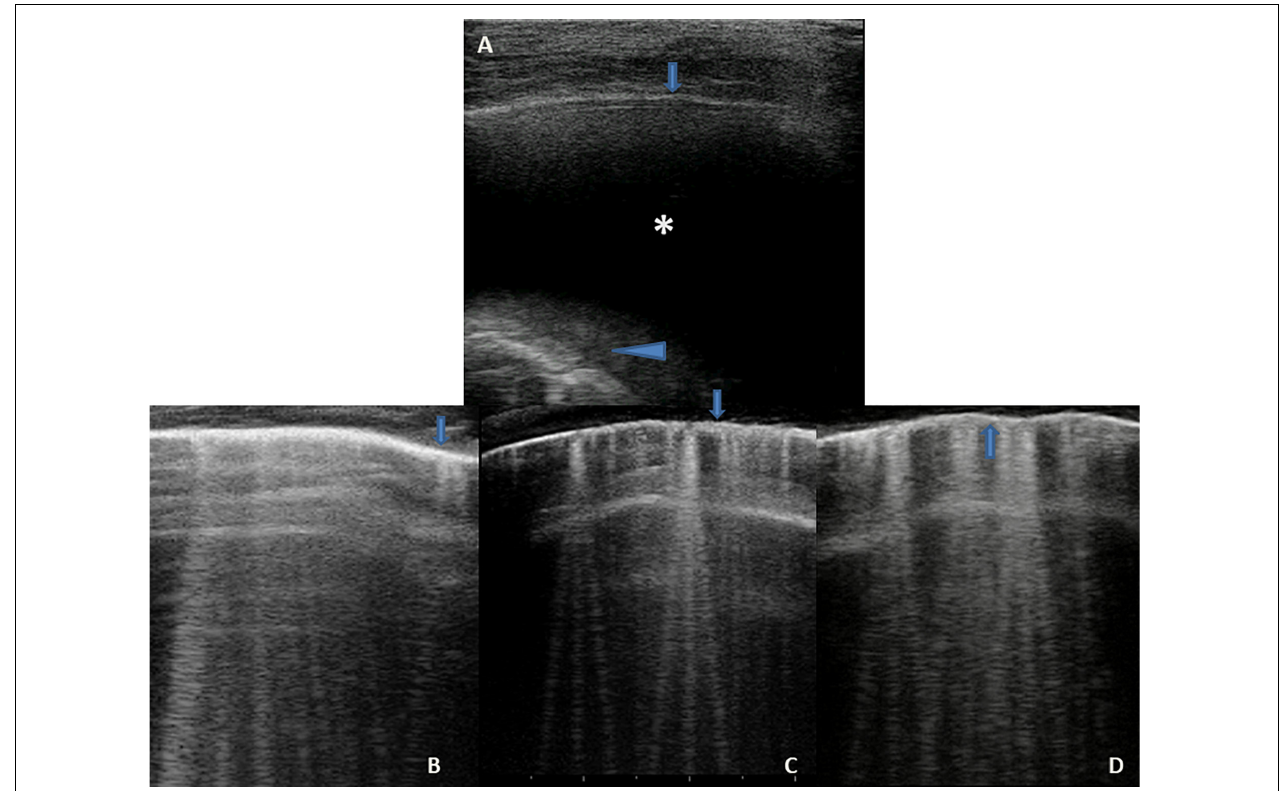
FIGURE 4 | Grayscale lung ultrasound examination (transverse scan between intercostal fields; linear probe with 12 MHz frequency) of a 10-year-old child with congestive heart disease resulting from untreated rheumatic carditis, shows in Panel (A) , on the basal posterior-lateral fields on the right, an anechoic pleural effusion ( asterisk ) that appears like an anechoic space between the parietal ( arrow ) and visceral pleura ( arrowhead ) below which lung appears atelectasis. Panels (B,C) show the SIS pattern of the upper right and left fields, respectively; Panel (D) shows that of the right lower/basal fields: the pleural line is regular ( arrows ); vertical artifacts or B-lines are separated, laser-like artifacts, with gravitational course spreading from the pleural line to the bottom of the screen and they show an internal sequence of alternating horizontal bands and homogeneous distribution in the affected spaces. Ultrasound picture compatible with the septal pattern of early CPE (Soldati and Demi, 2017; Soldati et al., 2019). CPE, cardiogenic pulmonary edema; SIS, sonographic interstitial